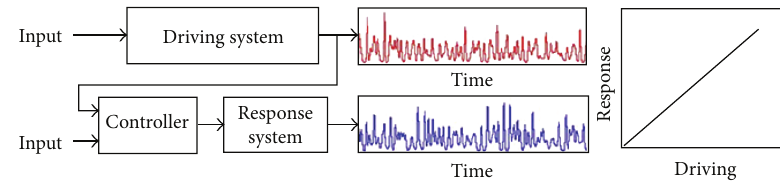
Figure 2: Behaviors of synchronized chaotic